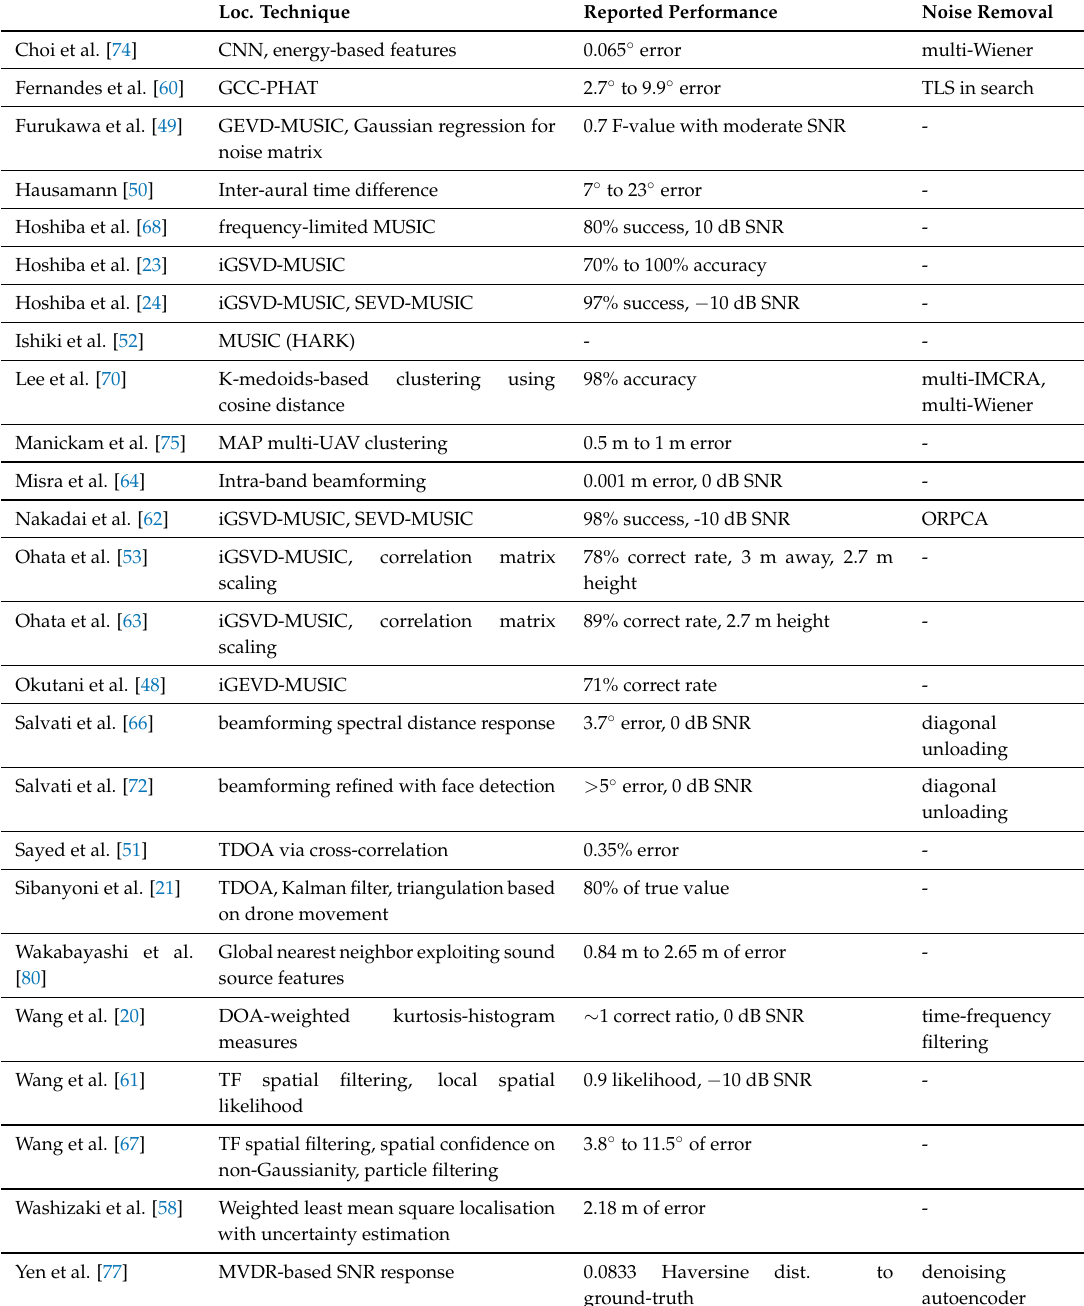
Table 3. Overview of land-to-air